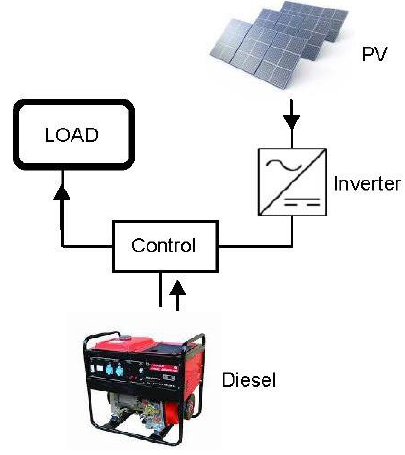
Figure 1. Off-grid PV + Diesel system.